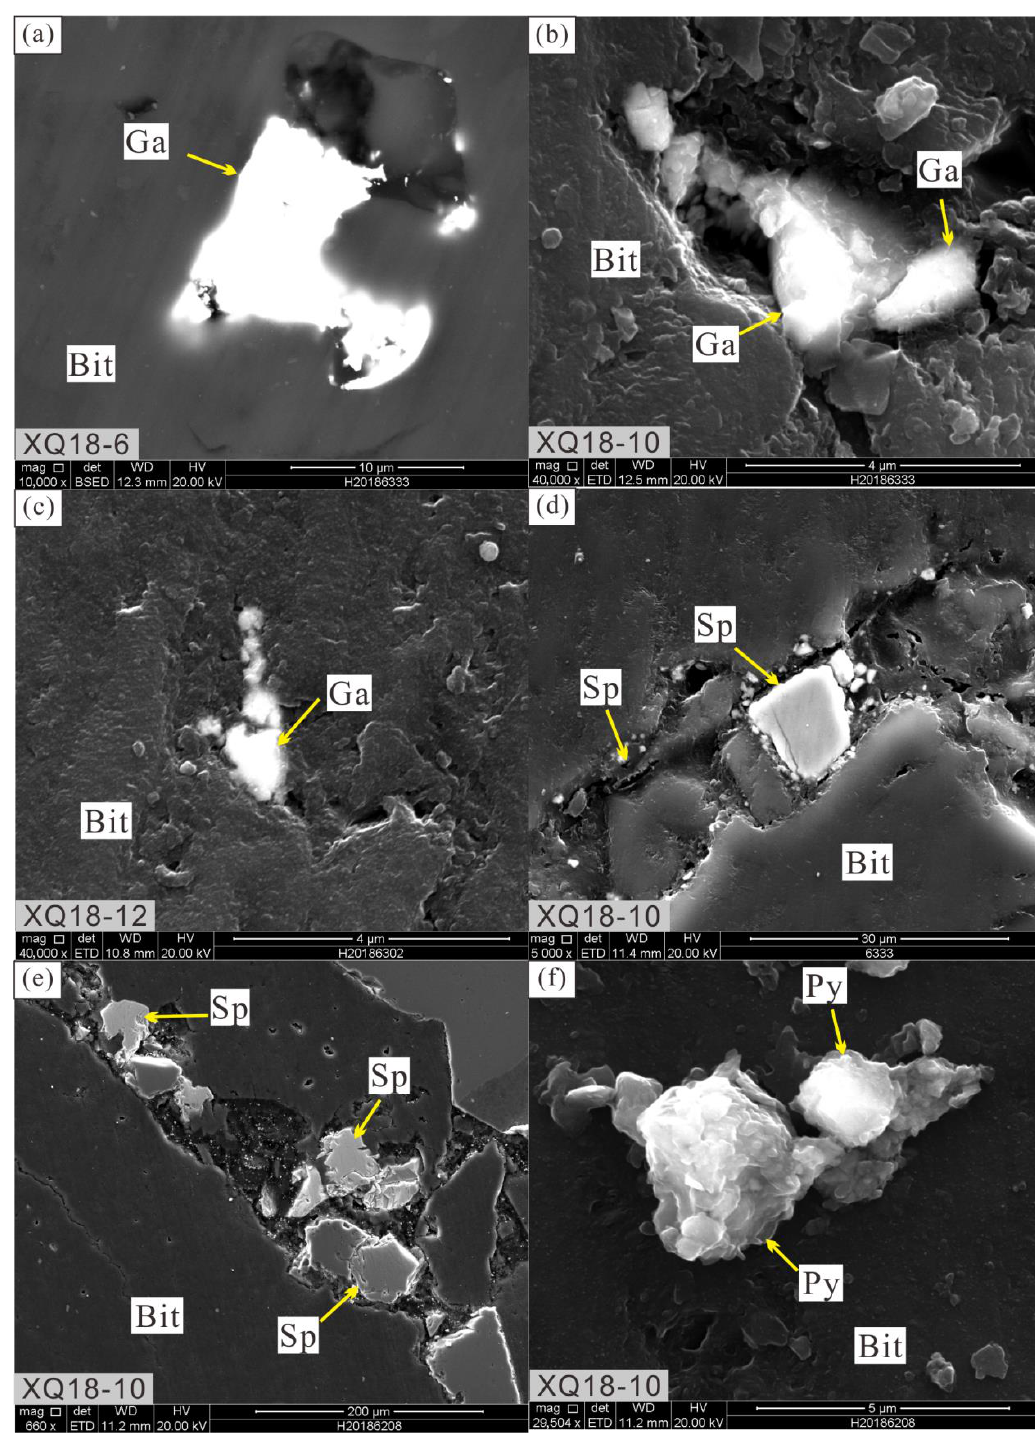
Figure 9. SEM and energy spectrum analytical results of bitumen (Bit) in paleo-oil/gas reservoirs at Xuequ. ( a – c ) Somegalenas in the bitumen; ( d , e ) Some sphalerites in the bitumen; ( f ) Some pyrites in the bitumen. Sp sphalerite, Ga galena, Py pyrite, Bit bitumen.